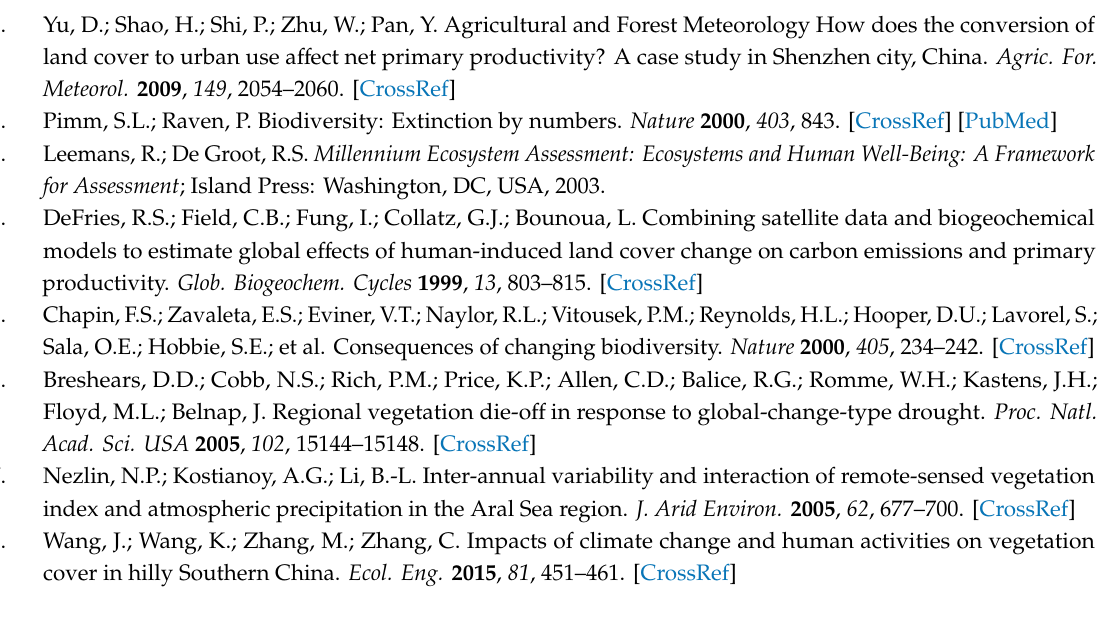
Figure S1: Validation of grid climate